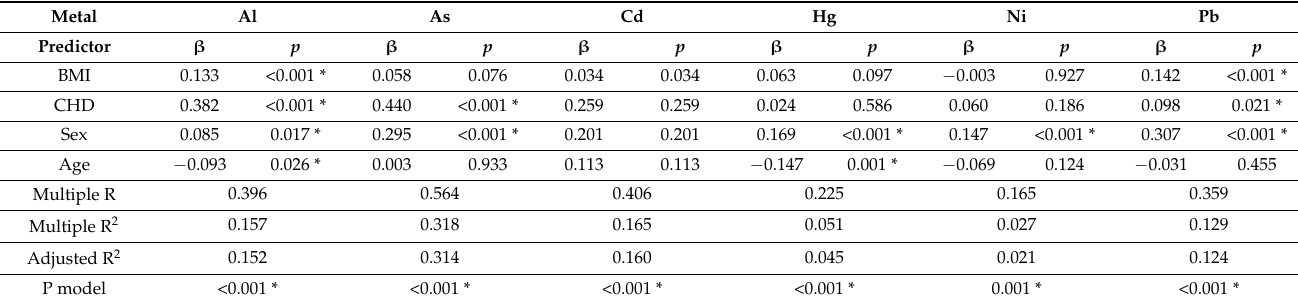
Table 6. Multiple linear regression analysis of the association between hair toxic metal levels (dependent variables) and BMI and CHD status (independent variables) after adjustment for age and sex of the